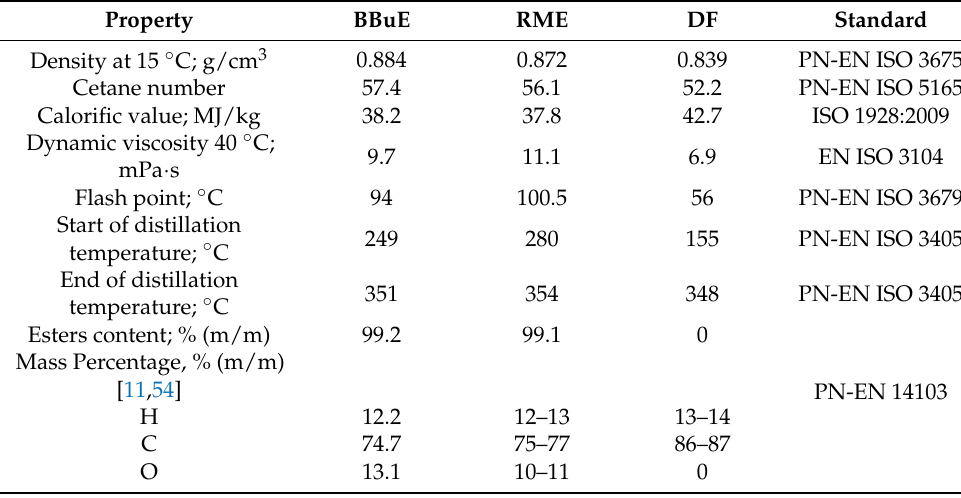
Table 3. Selected physicochemical properties of BBuE, RME and DF